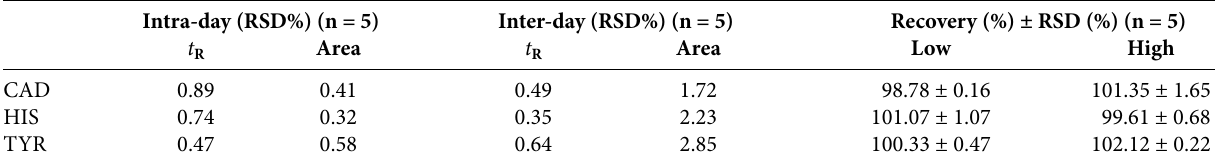
Table 3. Method accuracy and